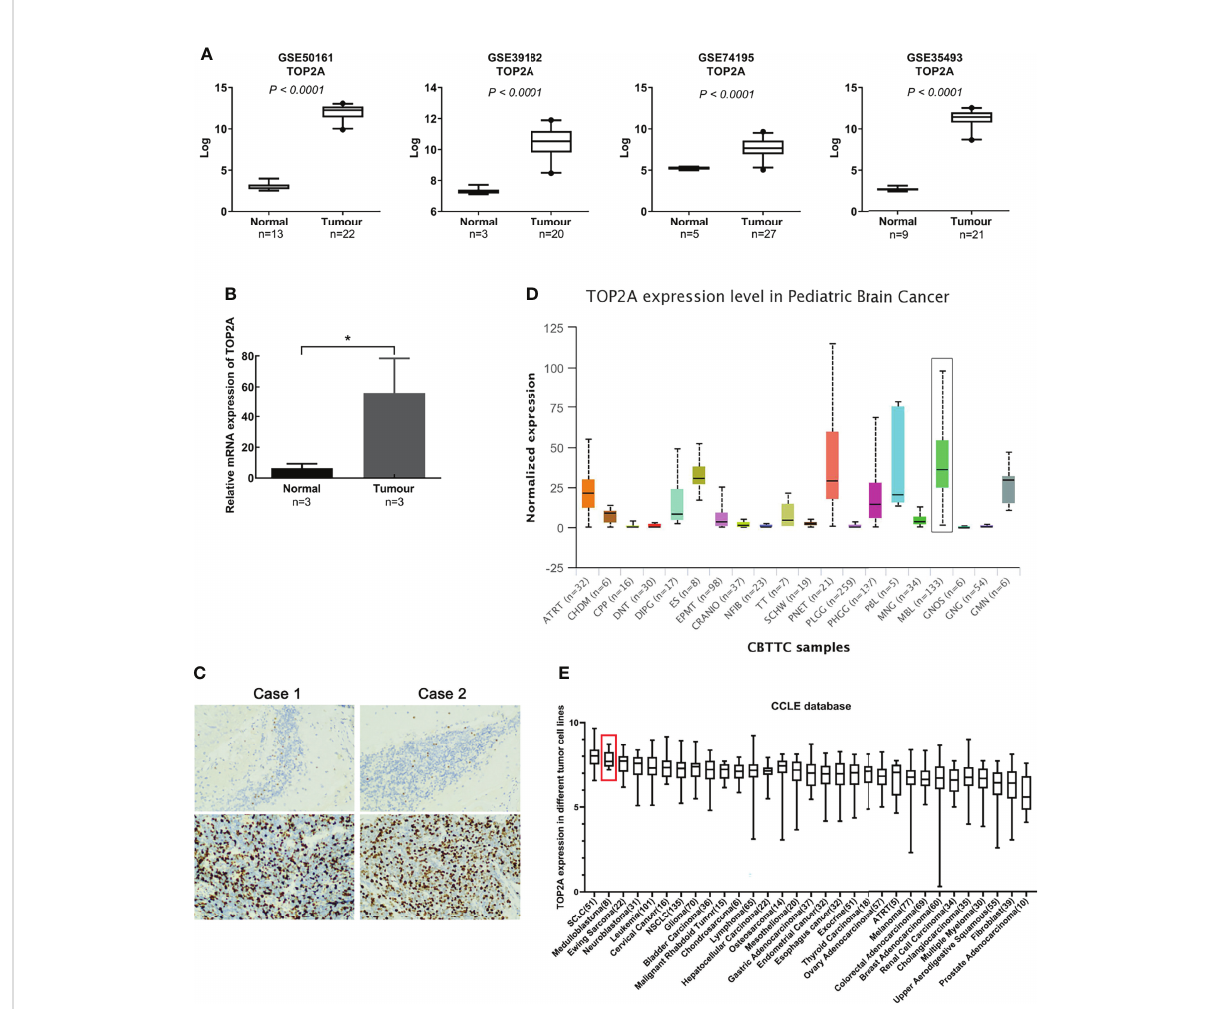
FIGURE 1 TOP2A is high expressed in MB. (A) The expression of TOP2A in normal brain tissues and MB tissues was analyzed according to microarray data (GSE50161, GSE39182, GSE74195 and GSE35493). Values are the median with 95% CI. (B) The expression of TOP2A in 3 pairs of MB tissues and corresponding normal brain tissues was analyzed through RT-qPCR analysis. Transcript levels were normalized to GAPDH expression. *P<0.05. (C) The expression of TOP2A in MB tissues and adjacent normal brain tissues was detected through IHC (magni fi cation × 200 in each picture). (D) The expression of TOP2A was assessed in 20 types of paediatric brain tumors with UALCAN, including MB (indicated by a black box). (E) The expression of TOP2A across various tumor cell lines, including MB cell lines (indicated by a red box), is shown in the CCLE